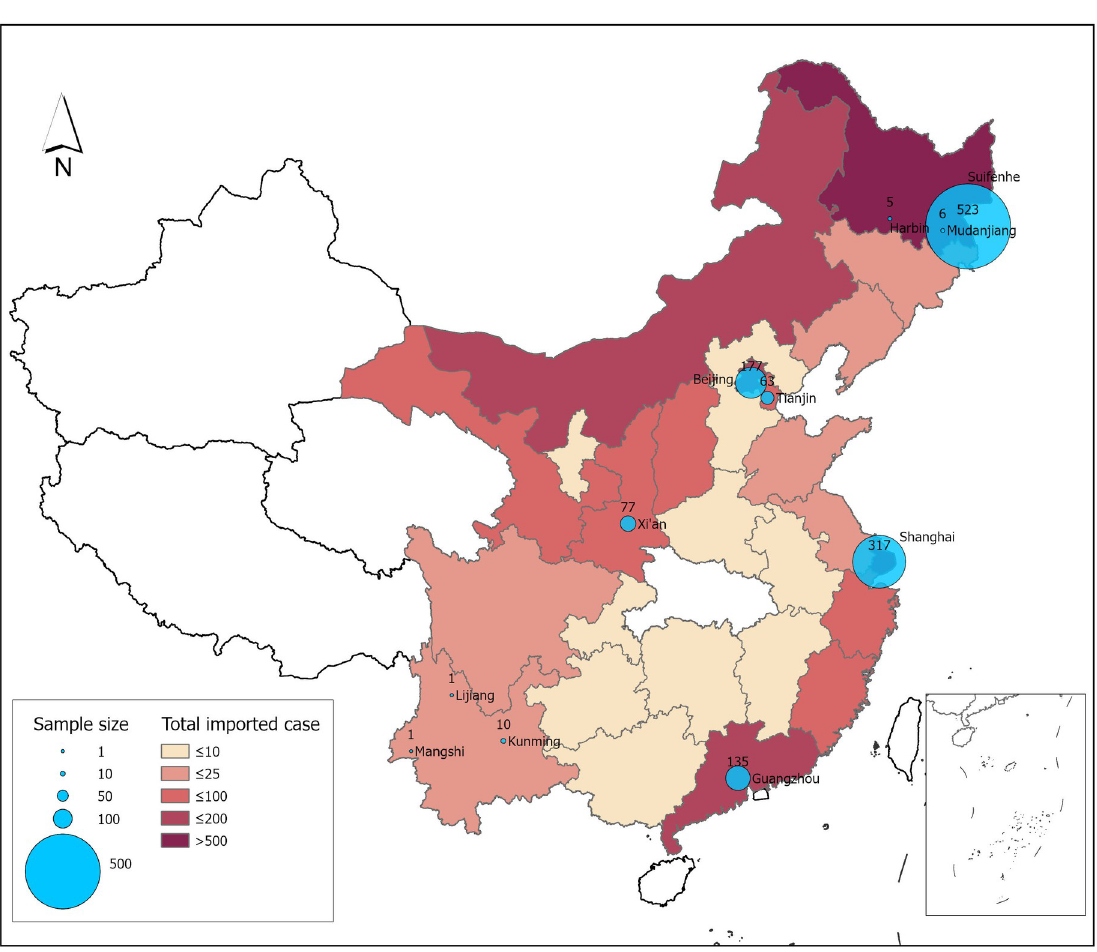
Fig 2. Spatial distribution of imported COVID-19 cases during Feb 29 –May 31, 2020. Note: Among the 1,314 cases we collected, 533 observations are from Heilongjiang province, 174 cases from Beijing, 66 from Tianjin, 317 from Shanghai, 77 from Xi’an, 12 from Yunnan province and 135 from Guangzhou of Guangdong